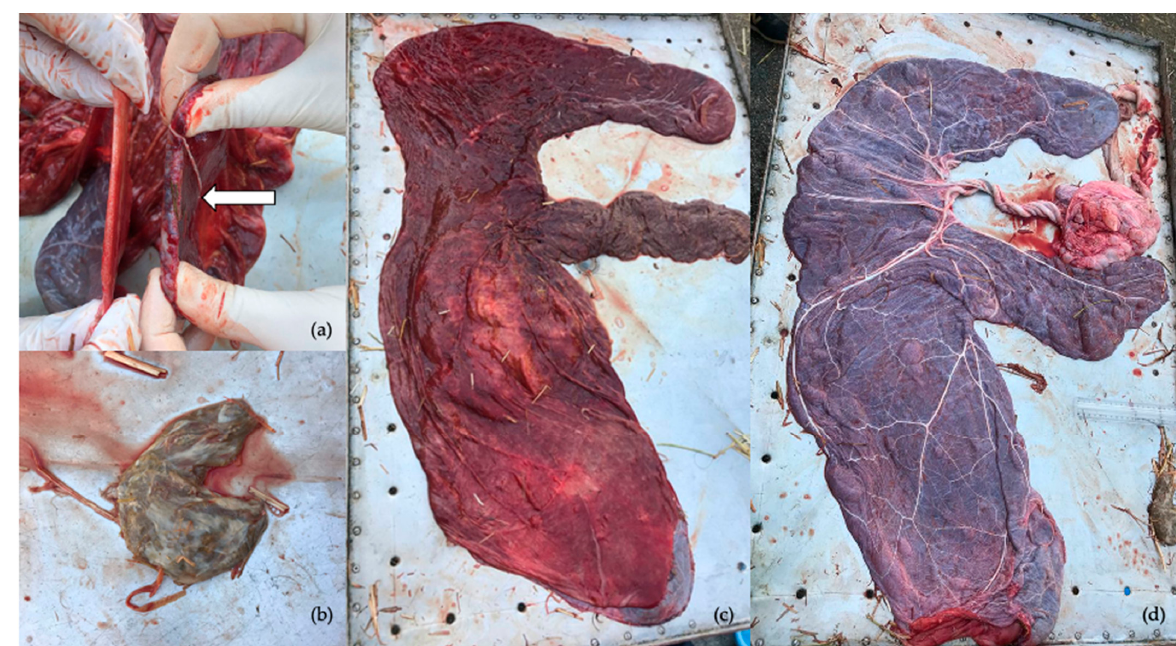
Figure 3. Gross examination of the fetal membranes ( a ) Thickening of a portion of the cervical star; ( b ) hippomane; ( c ) chorionic surface of fetal membranes; ( d ) allantoic surface.